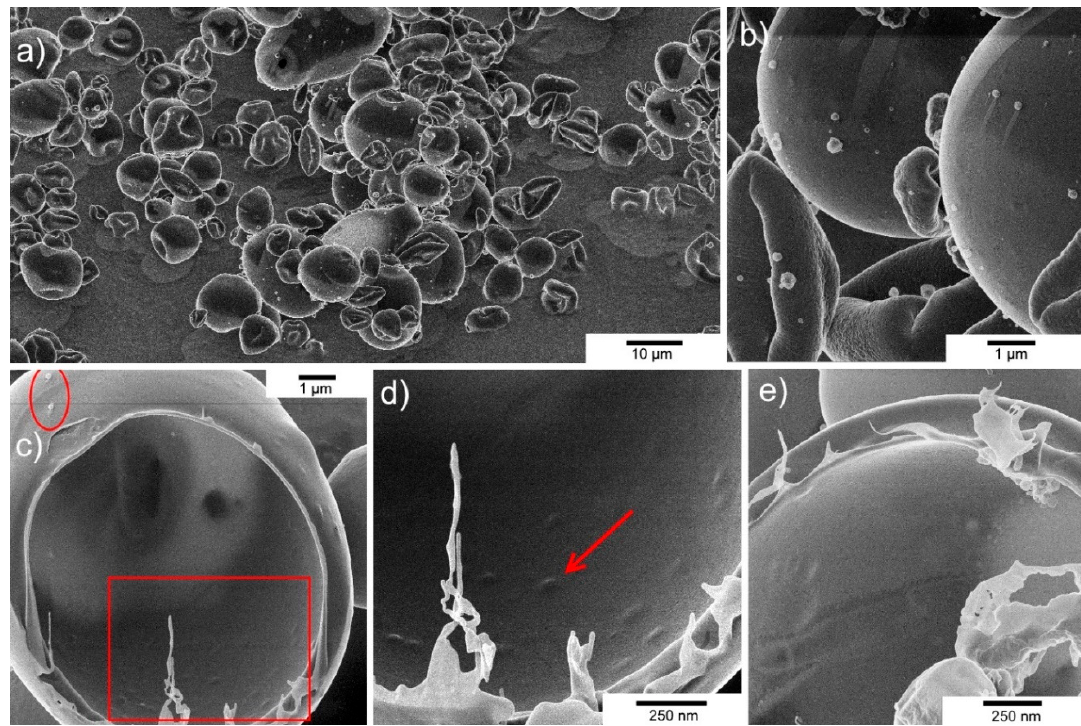
Figure 3. Helium ion microscopy (HIM) images of spray-dried PS21 microparticles (inlet drying temperature 150 °C). ( a ) Spray-dried microparticles were typically <10 µm in size and did not display surface defects such as blow holes. ( b ) Some particles were spherical, whereas others were flattened spheres, and some had a lens-shaped appearance. ( c ) A spherical particle about 10 µm in size was cut in half using a neon ion beam and, after 180° rotation, was imaged with a helium ion beam. Two phage virion particles can be seen in the top left-hand corner (red circle). ( d ) Expanded view of red box area shown in frame ( c ). Bumps in the inside wall of the sphere were found in microparticles containing phages imaged using a higher magnification (red arrow). ( e ) Inside wall of a control microparticle not containing phages.